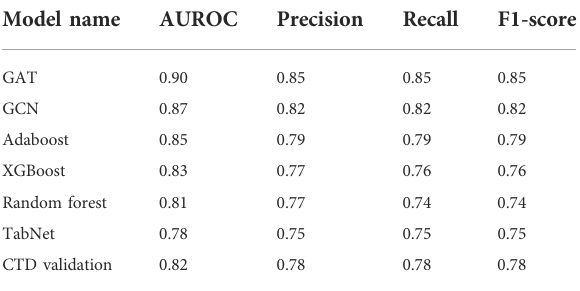
TABLE 1 Model evaluation metrics: AUROC, precision, recall, and F1